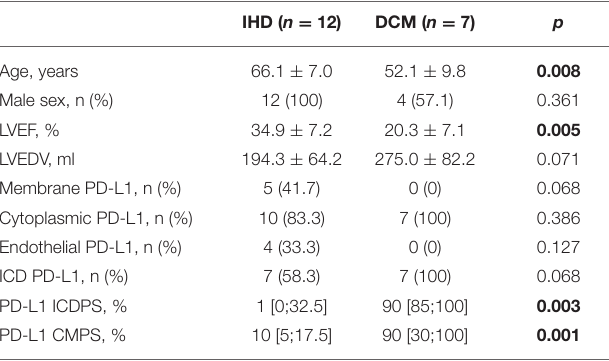
TABLE 1 | Clinical, echocardiographic, and immunohistochemical characteristics of